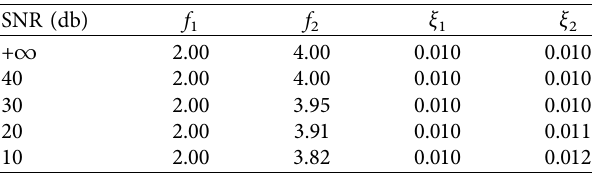
Table 3: Identification results for various SNRs with low-energy